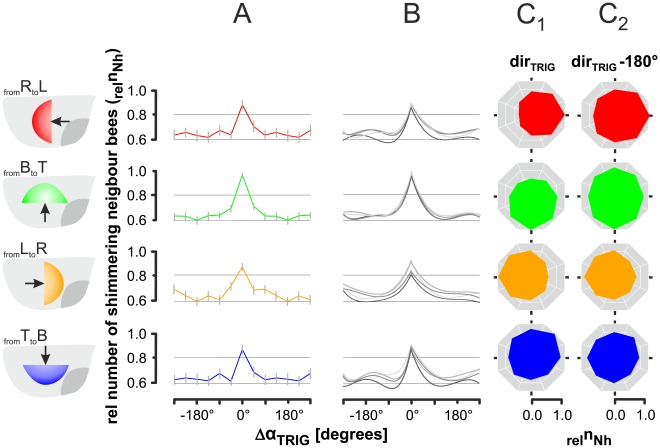
Proof of linearity and continuity in wave spreading of shimmering as documented by neighbour-bee related analysis.(A) Arithmetic means (curves) and SE (vertical bars) of the relative numbers of shimmering neighbours (relnNh) in the far neighbourhood (radiusNh<100 mm) around the focus bees regarding to the wave strength levels cws = 1-5; abscissa: ΔαTRIG | Nh, the deviation from the trigger angle in degrees at which the focus bees were activated to participate in shimmering, therefore ΔαTRIG | Nh = 0 refers to the trigger angle (trigger direction). Four data sets representing different spreading directions of shimmering waves (for colour codes, see Fig. 5): fromRtoL, nnb = 138190 neighbours; fromBtoT, 105356; fromLtoR, 159417; fromTtoB, 93199; (B) arithmetic means (curves) of the relative numbers of shimmering neighbours in the far neighbourhood (relnNh), considering four classes of wave strength levels were considered: darkest grey lines, cws = 4-5; brightest grey lines, cws = 1–2. The curves show the respective regression functions of the means (see Table S2); SEs are not shown. (C) Angular diagrams of relative numbers of shimmering neighbours (relnNh ) of only those focus bees selected for mid-level wave strength activation (cws = 3): fromRtoL, nnb = 4652 neighbours; fromBtoT, 4458; fromLtoR, 7182; fromTtoB, 2295; background sectors give the trigger angles αTRIG of the focus bees (C1) focus bees which were triggered in the direction where the wave had come from (equation 1a); (C2) focus bees which were triggered in the direction opposite to that under C1 (equation 1b).